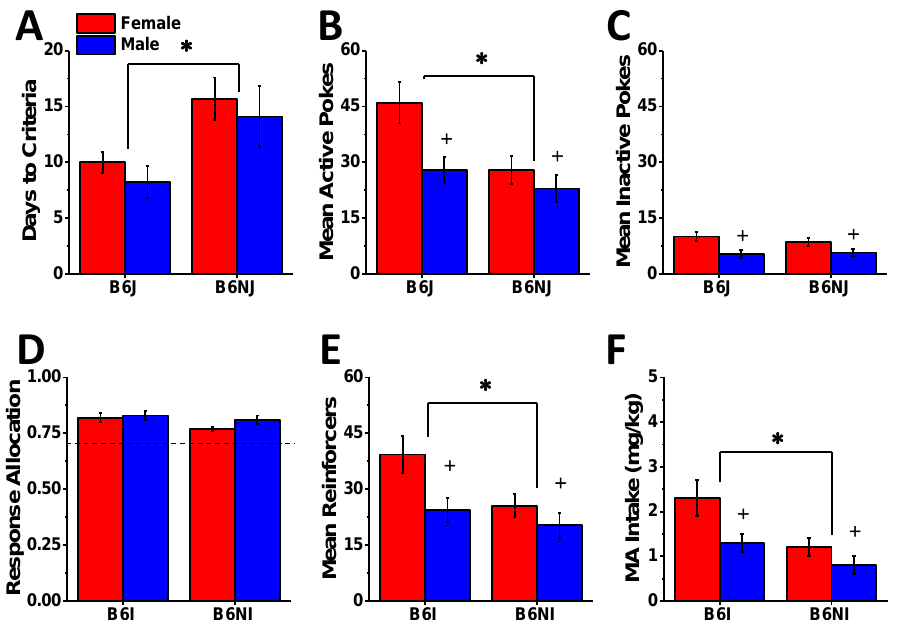
Figure 2. Summary of the substrain and sex differences in oral MA reinforcement during the acquisition phase of this study, highlighting the group differences in the number of days to reach the acquisition criterion ( A ) as well as the mean number of nose pokes into the active, MA-reinforced, hole ( B ), the inactive, non-reinforced hole ( C ), the relative allocation of responding in the active vs. inactive hole ( D ), the mean number of reinforcers earned ( E ), and the MA intake ( F ) over the last 3 days of self-administration. The data represent the mean ± SEM of 10–12 mice/sex/substrain. * represents a significant substrain effect, p < 0.05; + represents a significant sex effect, p < 0.05.